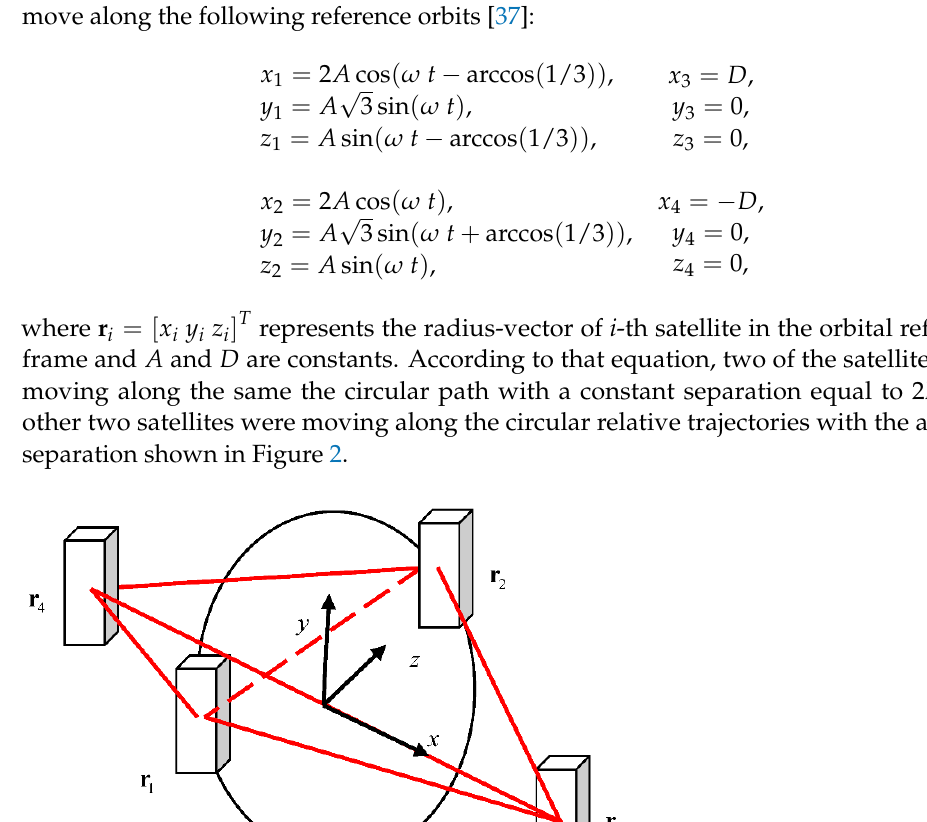
Figure 2. Scheme of the motion of the tetrahedral formation in LEO [37]. All the parameters used in the simulation of the controlled motion of the CubeSat formation flying are presented in Table 1. The constant atmosphere density corresponding to the average density for altitude of 340 km was used for the control calculation, though the actual atmosphere density corresponded to the GOST model. Thus, the density uncertainty for the decentralized algorithm was